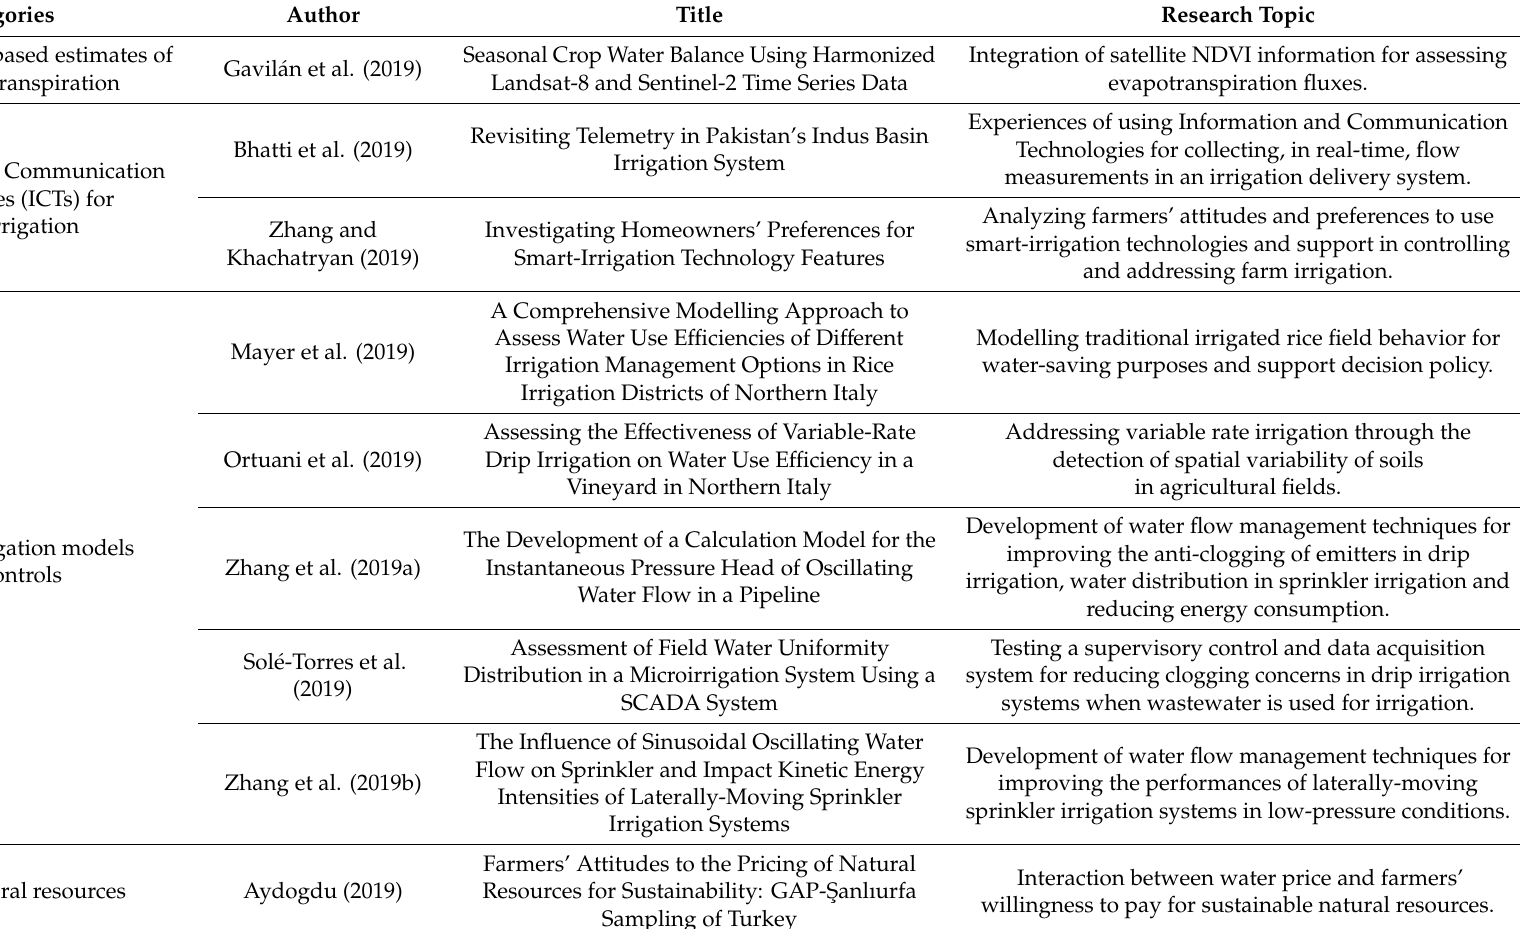
Table 1. Compendium of the works published in the Special Issue “Managing and Planning Water Resources for Irrigation: Smart-Irrigation Systems for Providing Sustainable Agriculture and Maintaining Ecosystem Services”. Categories, authors, title and topic are briefly summarized. NDVI: Normalized Di ff erence Vegetation Index; SCADA: supervisory control and data